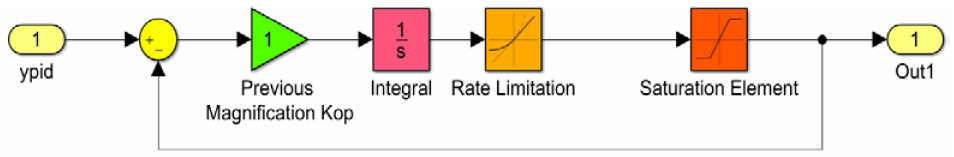
Figure 2. Block diagram of the PID controller in hydropower system. Parameters k p , k i and k d are the proportional adjustment coefficient, integral adjustment coefficient and differential adjustment coefficient, respectively.